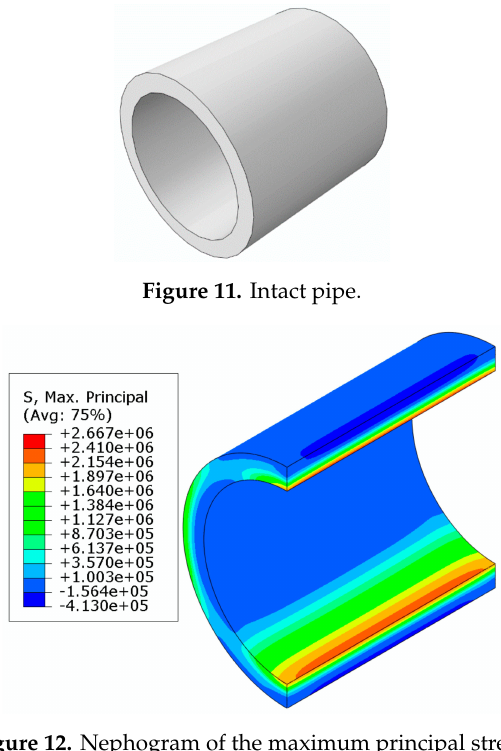
Figure 12. Nephogram of the maximum principal stress.